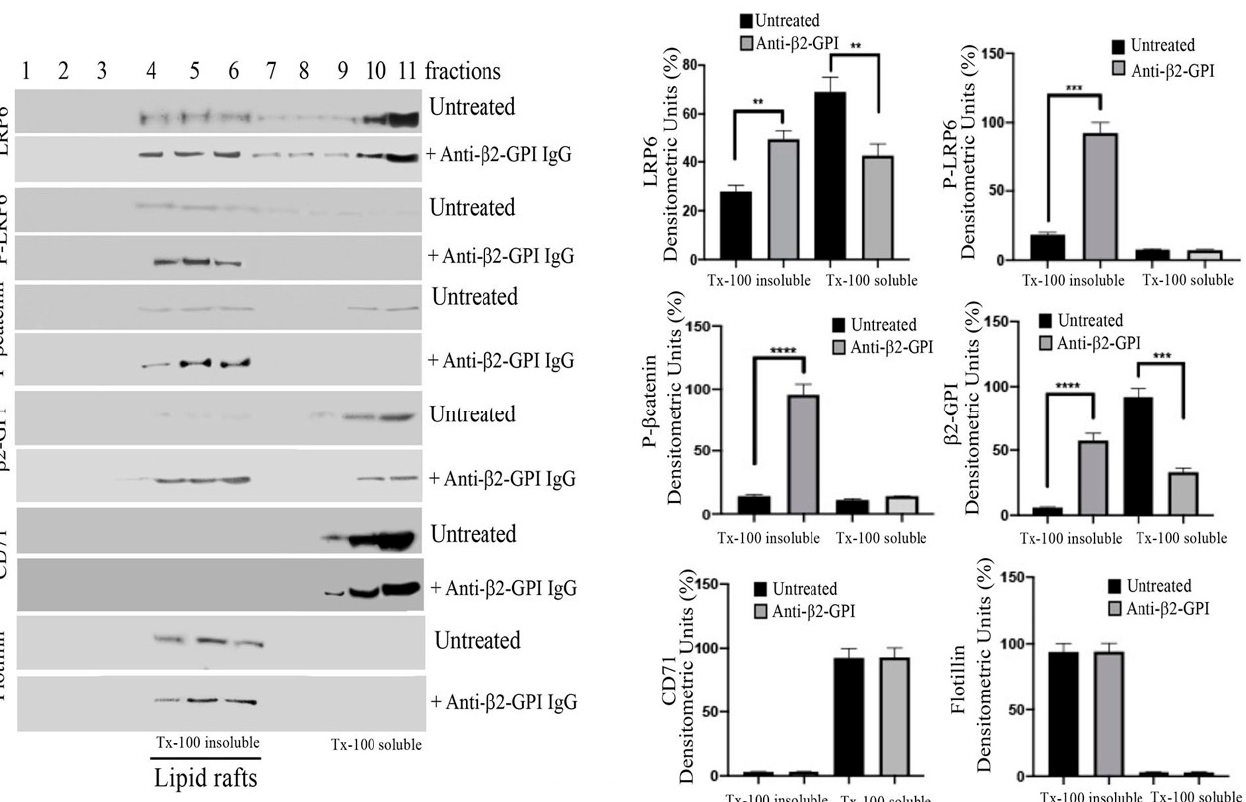
Figure 3. Lipid microdomains localization of LRP6 and β 2-GPI following triggering with anti- β 2-GPI antibodies. Sucrose gradient fractions obtained from HUVECs, untreated or treated with affinity- purified anti- β 2-GPI antibodies for 45 min, were analyzed by western blot using anti-LRP6 mAb, anti-phospho-LRP6 mAb, anti-phospho- β -catenin mAb, anti- β 2-GPI, anti-CD71 mAb or anti-flotillin Ab. Right panel. Bar graphs of densitometric analysis. The columns indicate the percentage distribution across the gel of raft fractions 4–5–6 (Triton X-100 insoluble fractions) and 9–10–11 (Triton X-100 soluble fractions), as detected by scanning densitometric analysis. Results represent the mean ± SD from three independent experiments. ** p < 0.005, *** p < 0.001, **** p < 0.0001.